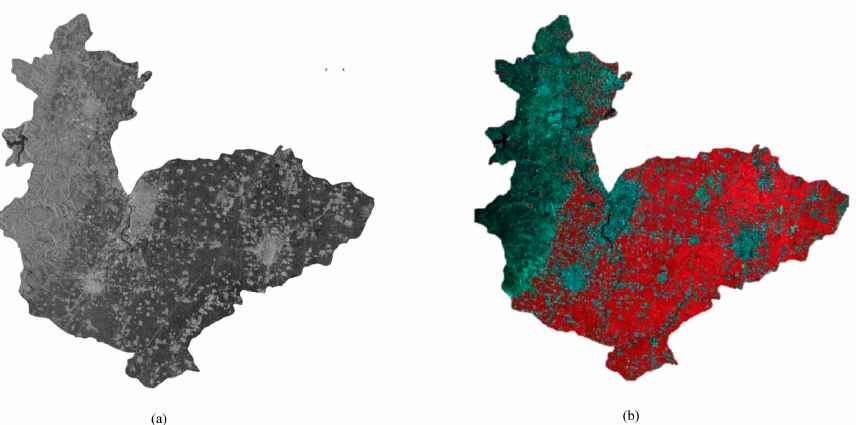
Figure 2. Remote sensing images of the study area. ( a ) Sentinel ‐ 1 SAR image (VV polarization). ( b ) Sentinel ‐ 2 composite false red green blue (RGB) images (Band 8 = red, Band 4 = green, and Band 3 = blue). Table 1. List of satellite ‐ based and in situ data used over the study area.